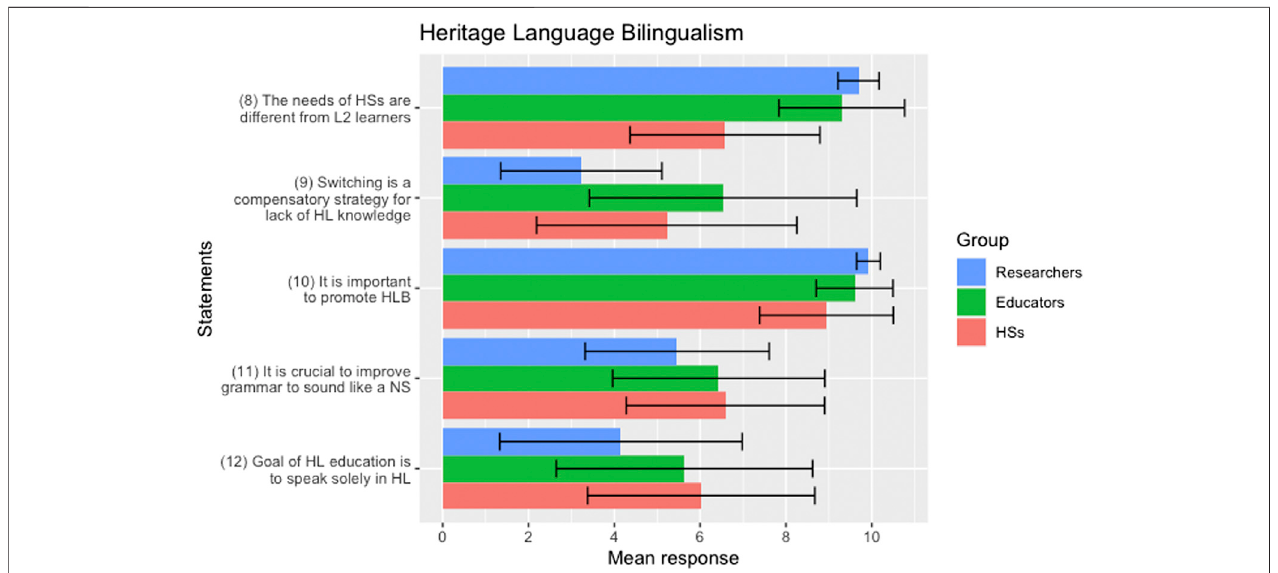
FIGURE 2 | Summary of the responses for questions related to HLB for HSs, Educators, and Researchers. Note: Participant responses are reported on a scale from 0 “ Strongly Disagree ” to 10 “ Strongly Agree. ”